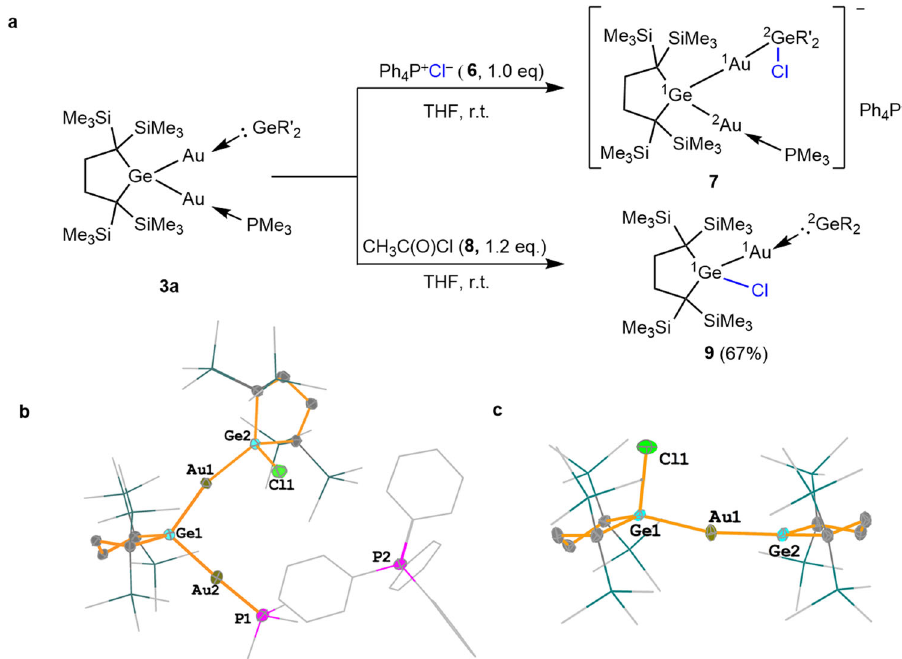
Fig. 5 Reactivity of 3a and structural characterization of products. a The reactions of 3a with tetraphenylphosphonium chloride (Ph 4 PCl) 6 , and acetyl chloride. b Molecular structure of 7 (Hydrogen atoms are omitted for clarity. Trimethylsilyl, ethyl, phenyl and methyl groups are depicted in a wireframe model). c Molecular structure of 9 (Hydrogen atoms are omitted for clarity. Trimethylsilyl, ethyl, phenyl and methyl groups are depicted in a wireframe